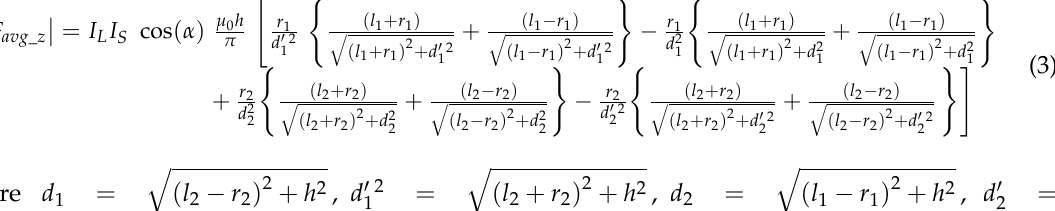
magnitudes of the source current and the load current, as well as the phase difference between the source current and the load current (α ≠ 90°).